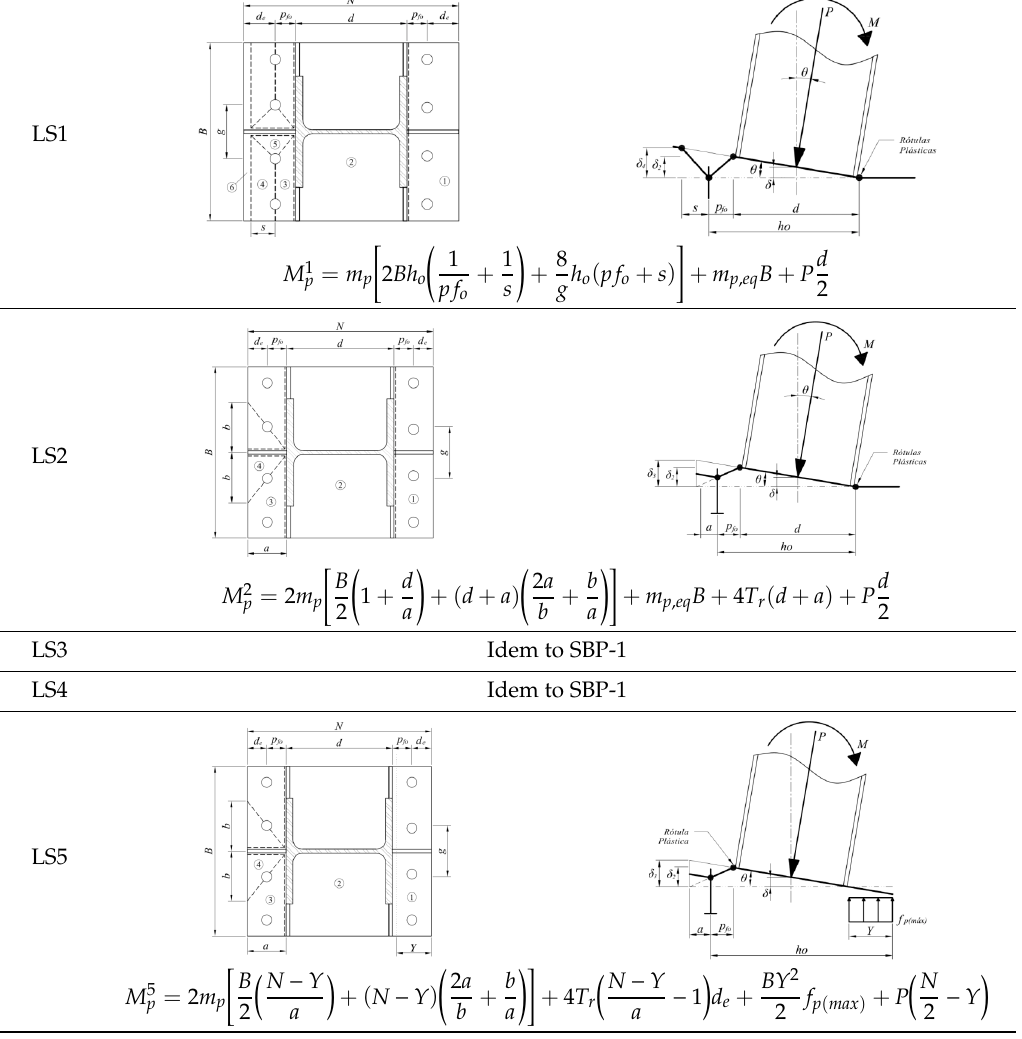
Table 6. Limit states that control the design of base plate type SBP-3.